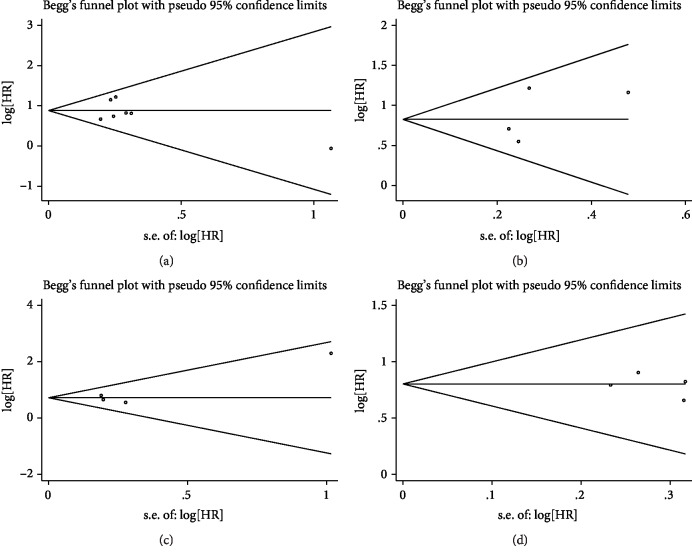
Analysis of publication bias. (a) Begg's funnel plot about the association between GPS and OS. (b) Begg's funnel plot about the association between GPS and DSS. (c) Begg's funnel plot about the association between GPS and DFS. (d) Begg's funnel plot about the association between CAR and OS.